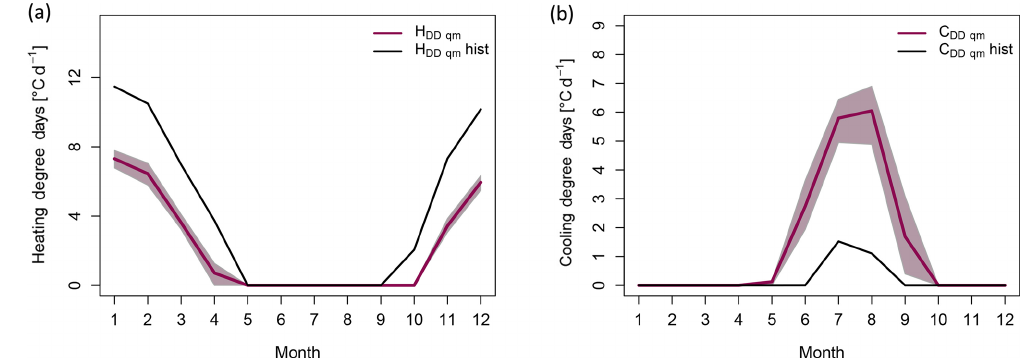
Figure 7. Mean monthly (a) H DD and (b) C DD for the canton of Geneva. The mean of the historical simulations (1980–2009; gray) are compared to the future simulations under the influence of RCP8.5 climate change scenario (2070–2099; purple). The mean (solid lines) and likely range (shaded areas) are shown, where the likely range represents two-thirds of the simulations. Groupe E prescribed thresholds of 13 and 18.3 ◦ C to compute H DD and C DD ,